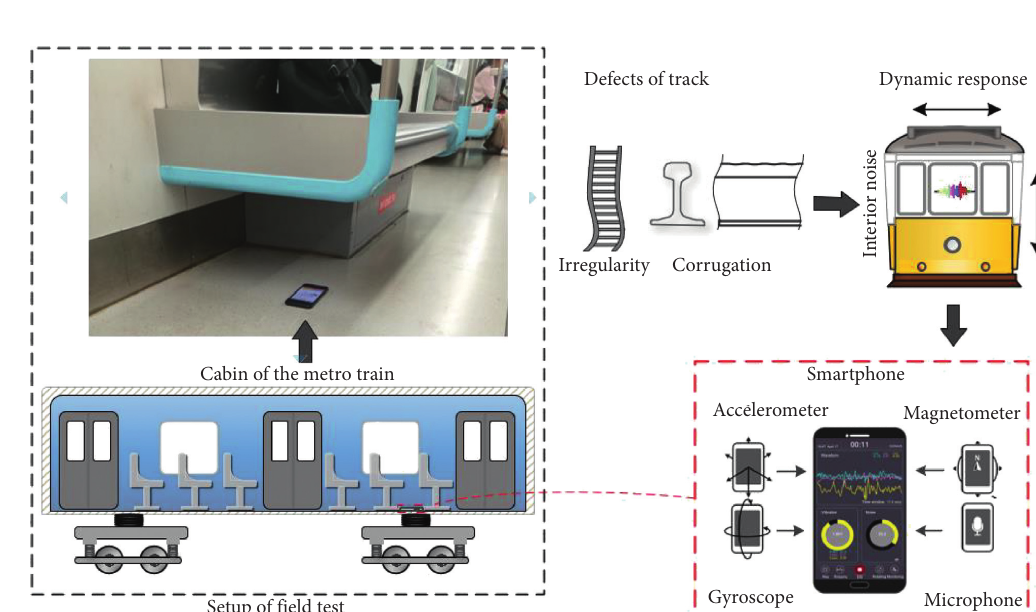
Figure 2: Research methodology.